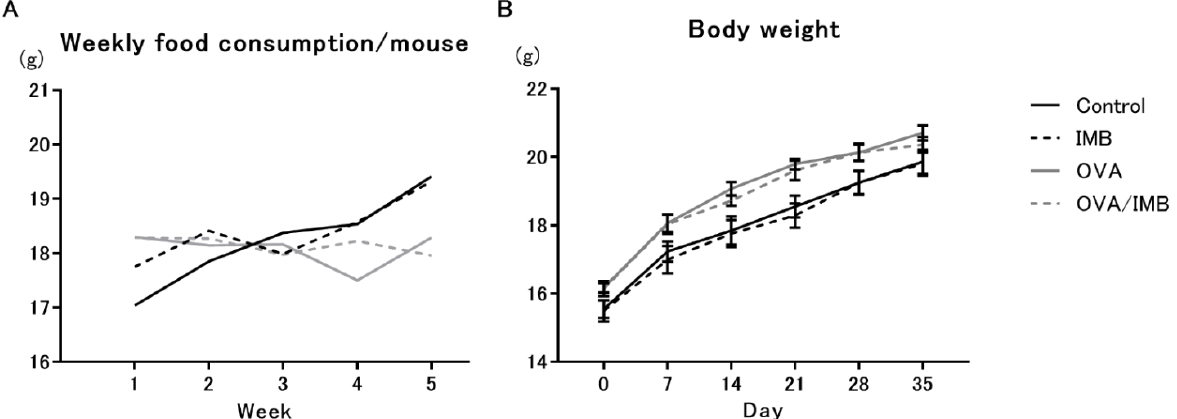
Figure 2. The amount of weekly food consumption ( A ) and the body weight changes ( B ) in each group. Values represent the mean ± standard error of the mean.